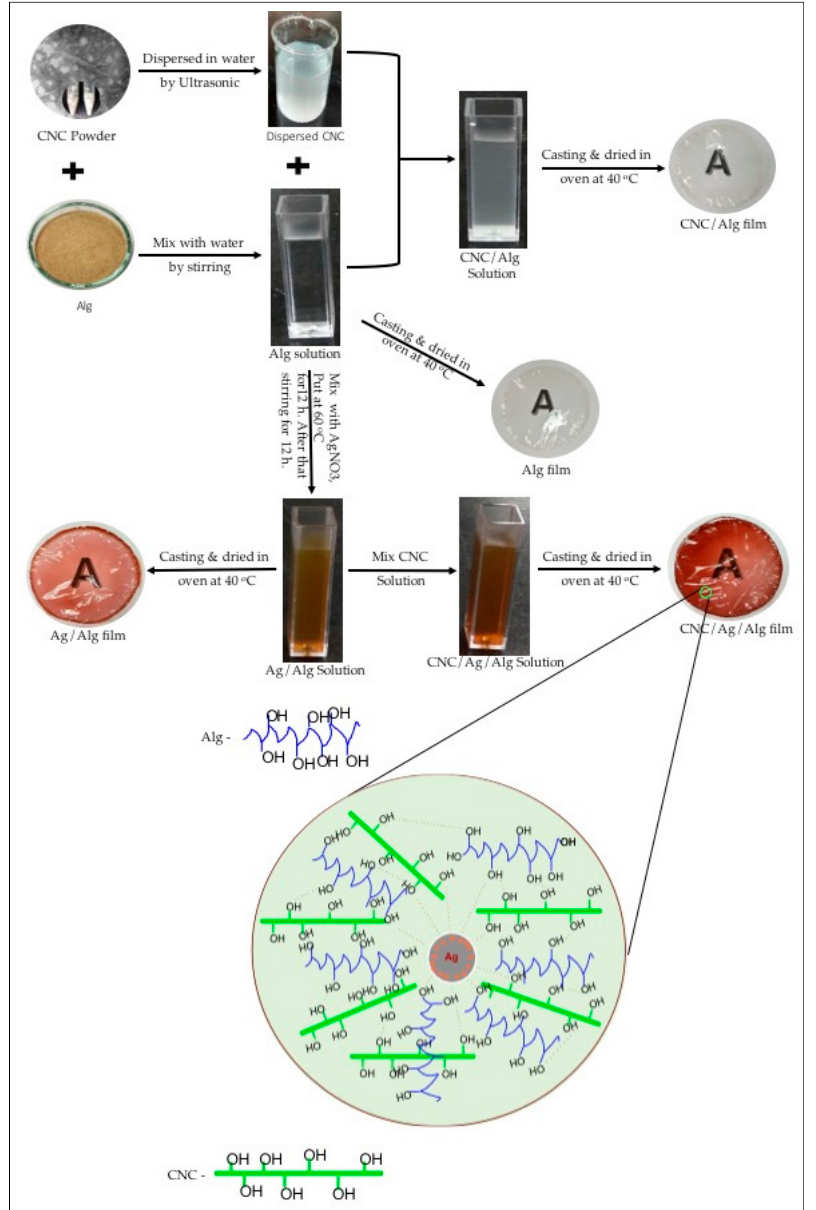
Figure 1. Schematic representation of fabricated solutions and films of alginate (Alg), cellulose nanocrystal (CNC) / Alg, silver (Ag) / Alg, and CNC / Ag /